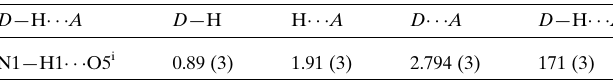
Table 1 Hydrogen-bond geometry (A˚ , (cid:3) ).